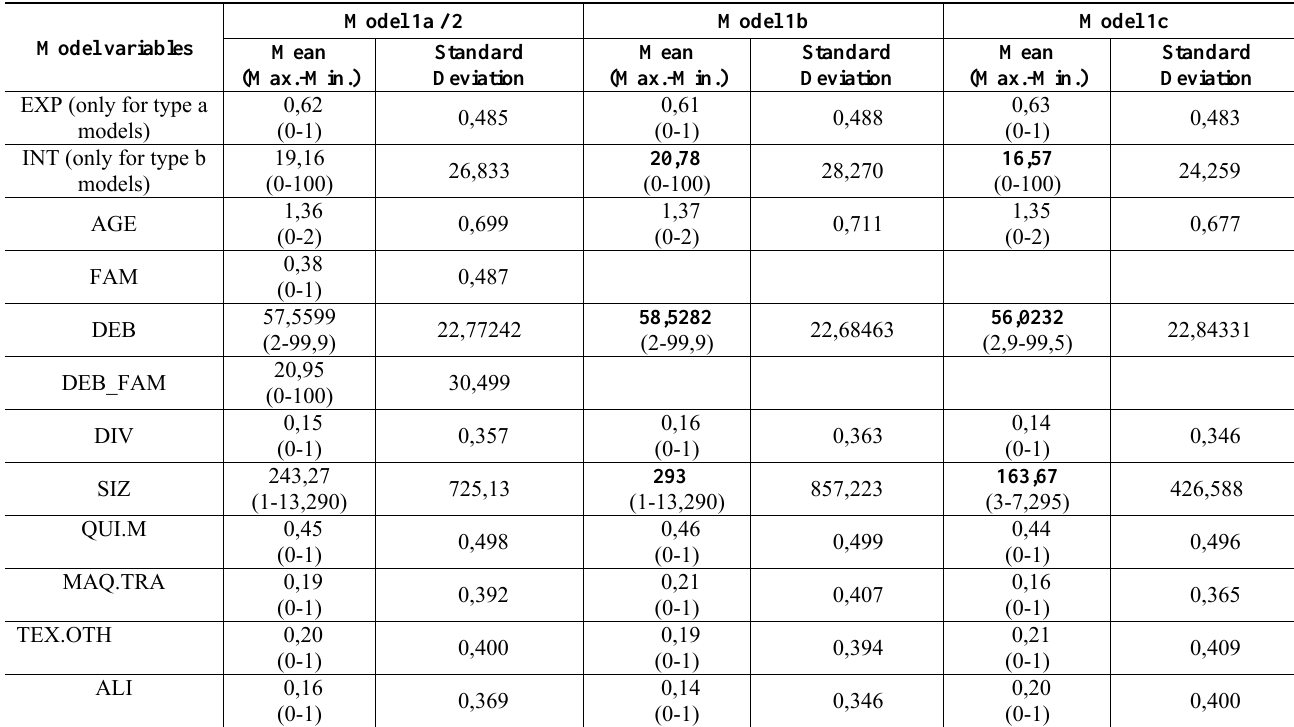
Table 6: Descriptive statistics